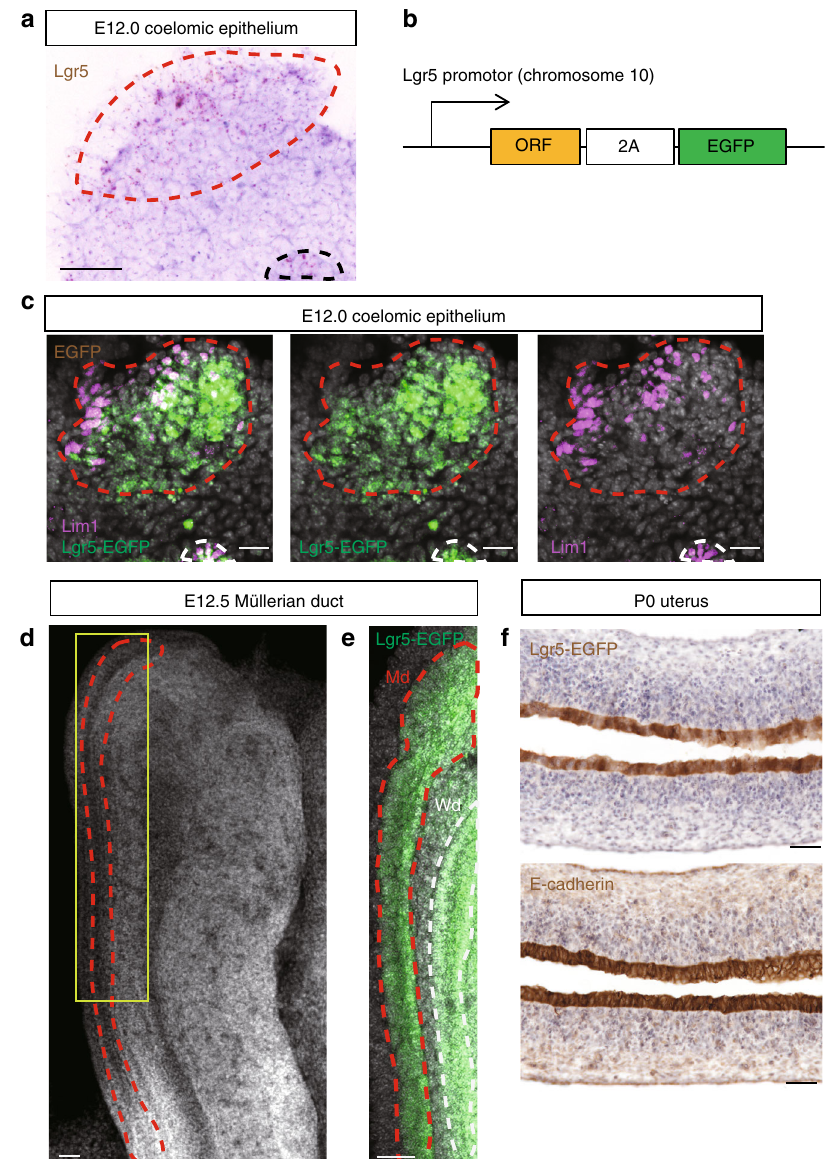
Fig. 1 Lgr5 is expressed in the early female reproductive tract during embryogenesis. a RNA ISH for Lgr5 in coelomic epithelium at E12.0. b The Lgr5-2A- EGFP mouse model employed to evaluate endogenous Lgr5 expression. c Co-IF for Lgr5-EGFP and Lim1 in coelomic epithelium at E12.0. d Confocal z-stack image of a whole-mount E12.5 Müllerian duct (highlighted by the red dashed line). Yellow box indicates the region magni fi ed in e . e Endogenous EGFP fl uorescence in E12.5 Lgr5-2A-EGFP mouse at Md. f Immunostaining for Lgr5-EGFP and E-cadherin in P0 uterus. Dashed red lines indicate Md, and dashed black or white lines indicate Wd, respectively. Md, Müllerian duct; Wd, Wolf fi an duct; Scale bars, 50 μ m. All images are representative of three independent